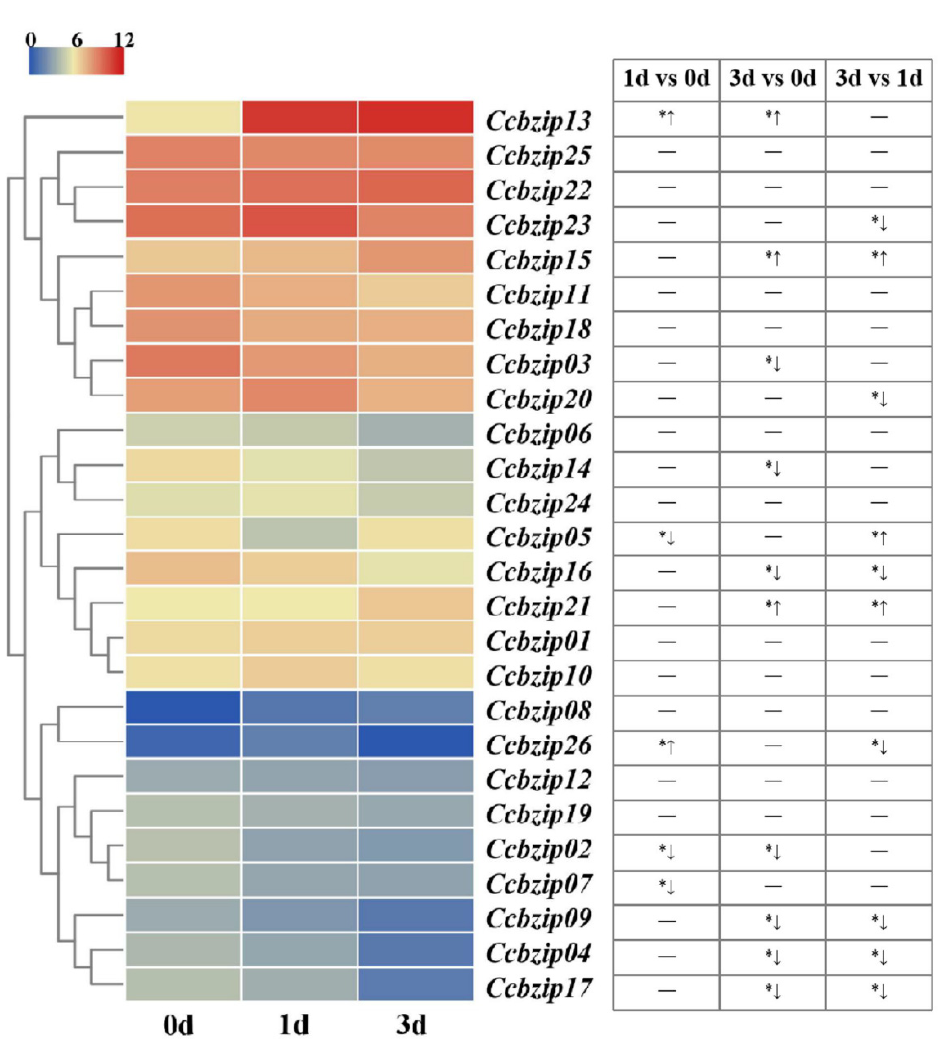
Figure 4. The expression patterns of CcbZIPs at the initial infection stages. The heatmap shows the expression data of each CcbZIPs . The original FPKM values of CcbZIP genes were transformed by log2. The color scale ranging from blue to red indicates the increased expression levels. The differentially expressed genes (|log2foldchange| ≥ 1, p < 0.05) are indicated with *. The up arrows represent significantly up-regulated, while the down arrows represent significantly down-regulated.